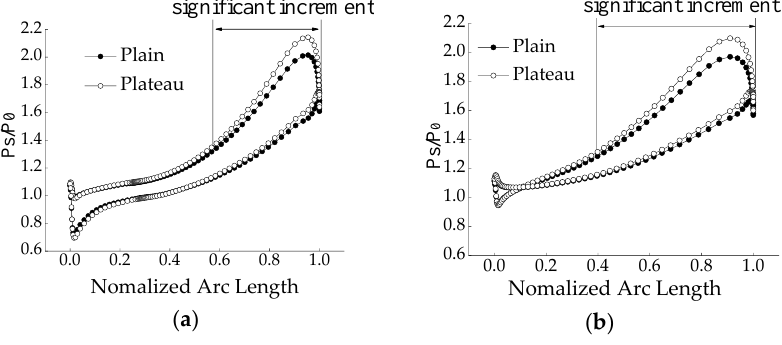
Figure 11. Load distribution of blade surface at 10% blade span: ( a ) main blade; ( b ) splitter blade.